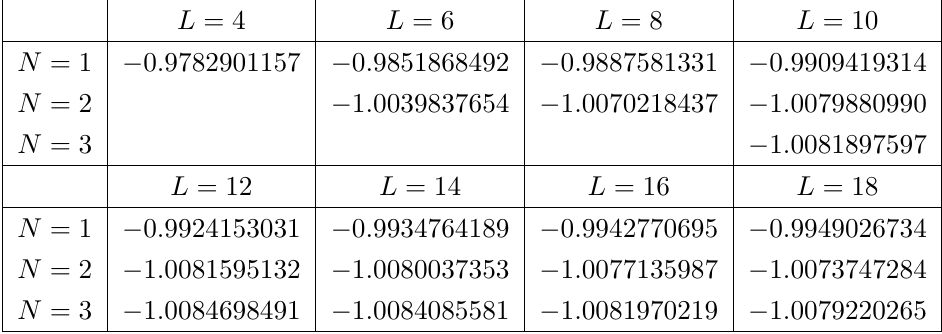
Table 10 . Pad(cid:19)e extrapolation values for the vacuum energy in Schnabl gauge from L = 4 to L = 18. The value of the entries where (4 N (cid:0) 2 = L ) coincide with the direct ( L; 3 L ) level- truncation computations.